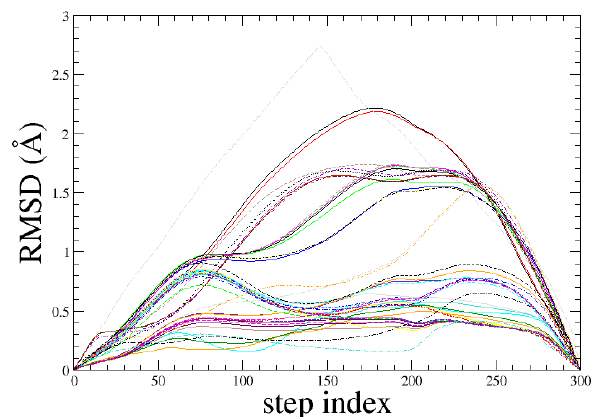
Figure 9. The lowest energy-barrier pathway is compared to the other 49 ADMD pathways by calculating RMSD values between two corresponding conformations. We find that calculated RMSD values are less than 1 Å over all ADMD step indices for 35 pathways out of 49. For the other 14 folding models, calculated RMSD values are below 3